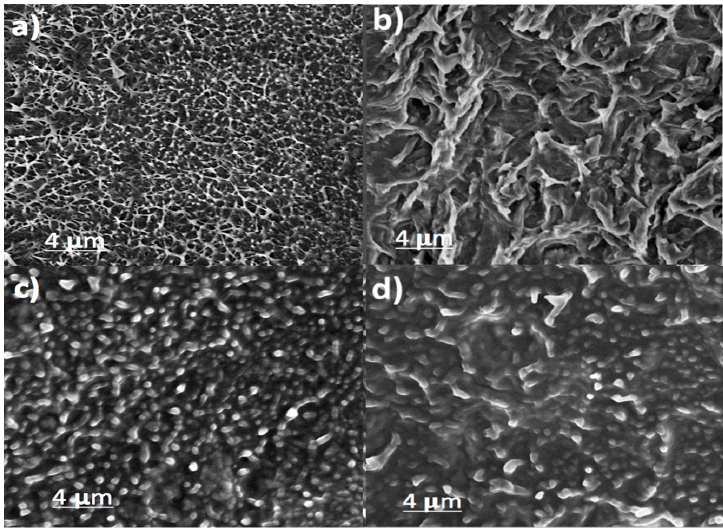
Figure 4. SEM images of cross-sections of samples: ( a ) PVDF; ( b ) PVDF/rGO; ( c ) PVDF/TNL; and ( d ) PVDF/rGO-TNL.